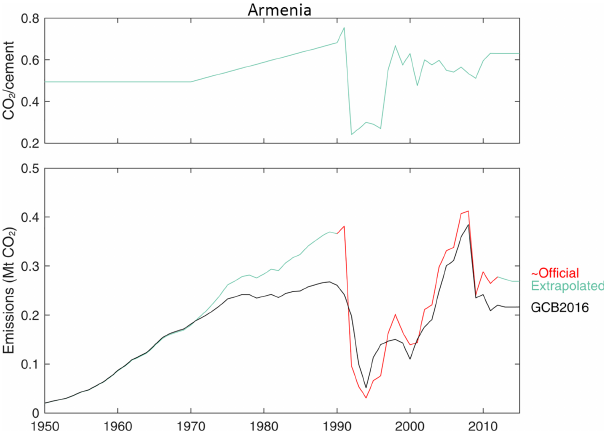
Figure D13. Revised cement emissions for Azerbaijan.